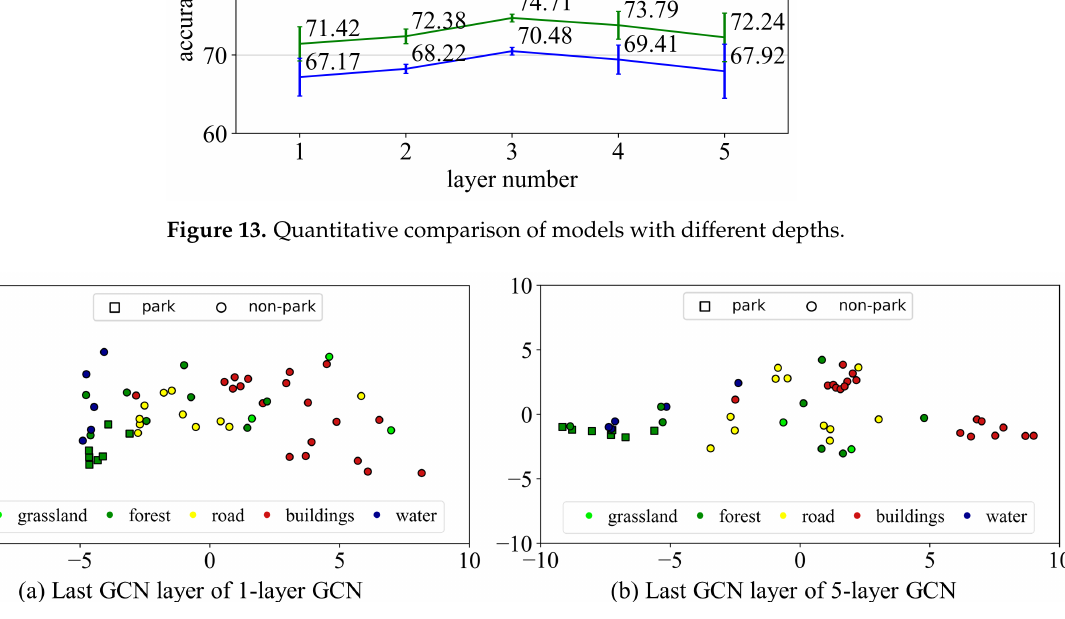
Figure 14. The feature distributions of the last GCN layer in 1-layer CHeGCN and 5-layer